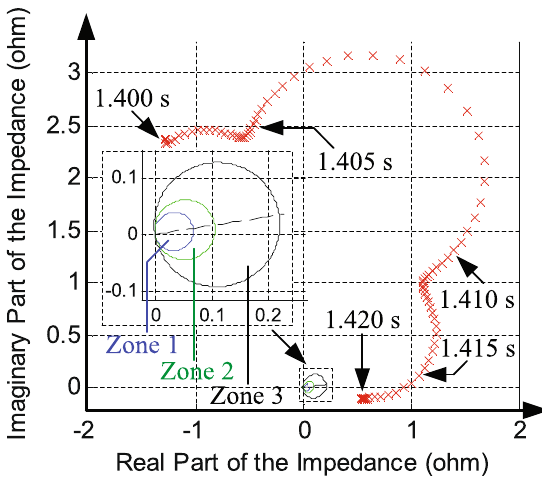
Fig. 13 Calculated impedance trace of event 3: external bolted fault, grid-connected mode